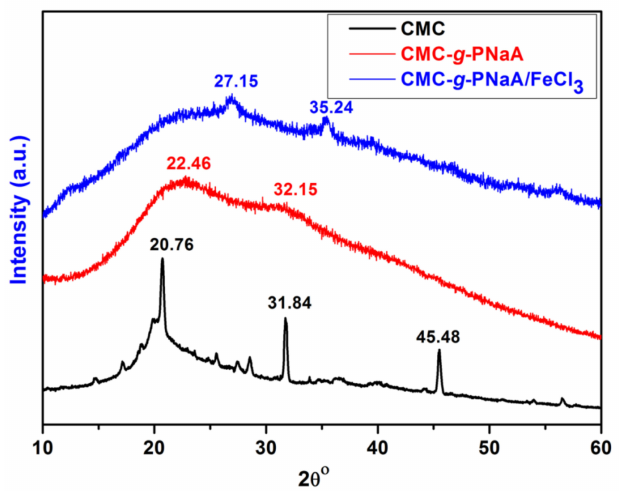
Figure 4. X-ray di ff raction (XRD) patterns of CMC, CMC- g -PNaA and CMC- g -PNaA / FeCl 3 hydrogel